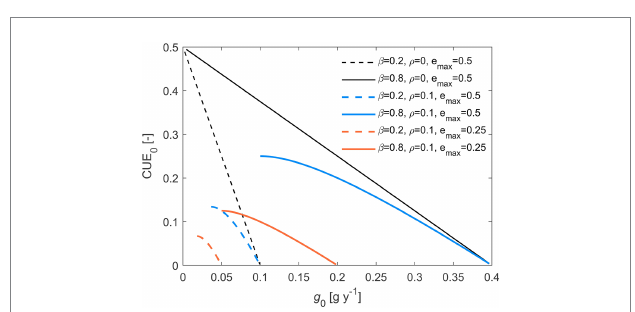
FIGURE 5 Trade-off between initial microbial C-use efficiency ( CUE 0 ) and initial growth rate ( 0 g ), when varying the C loss rate constant ( g , increasing from 10 − 4 to 10 4 y − 1 left to right along the curves). Line styles refer to different combinations of the half saturation constant ( b ), maintenance respiration rate ( r ), and maximum microbial growth efficiency ( max e ). Other parameters: 0 c = 1 g, m= 0.5. Parameter units are as in Table 1.